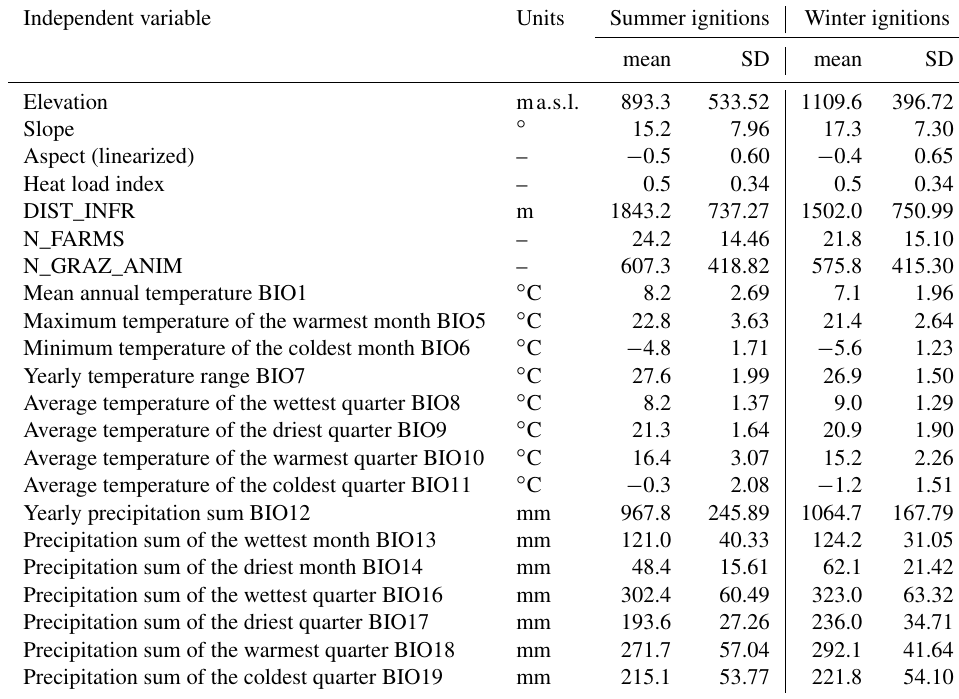
Table 1. Summary statistics of the candidate predictors for fire ignition across all ignitions points in the study area. Independent